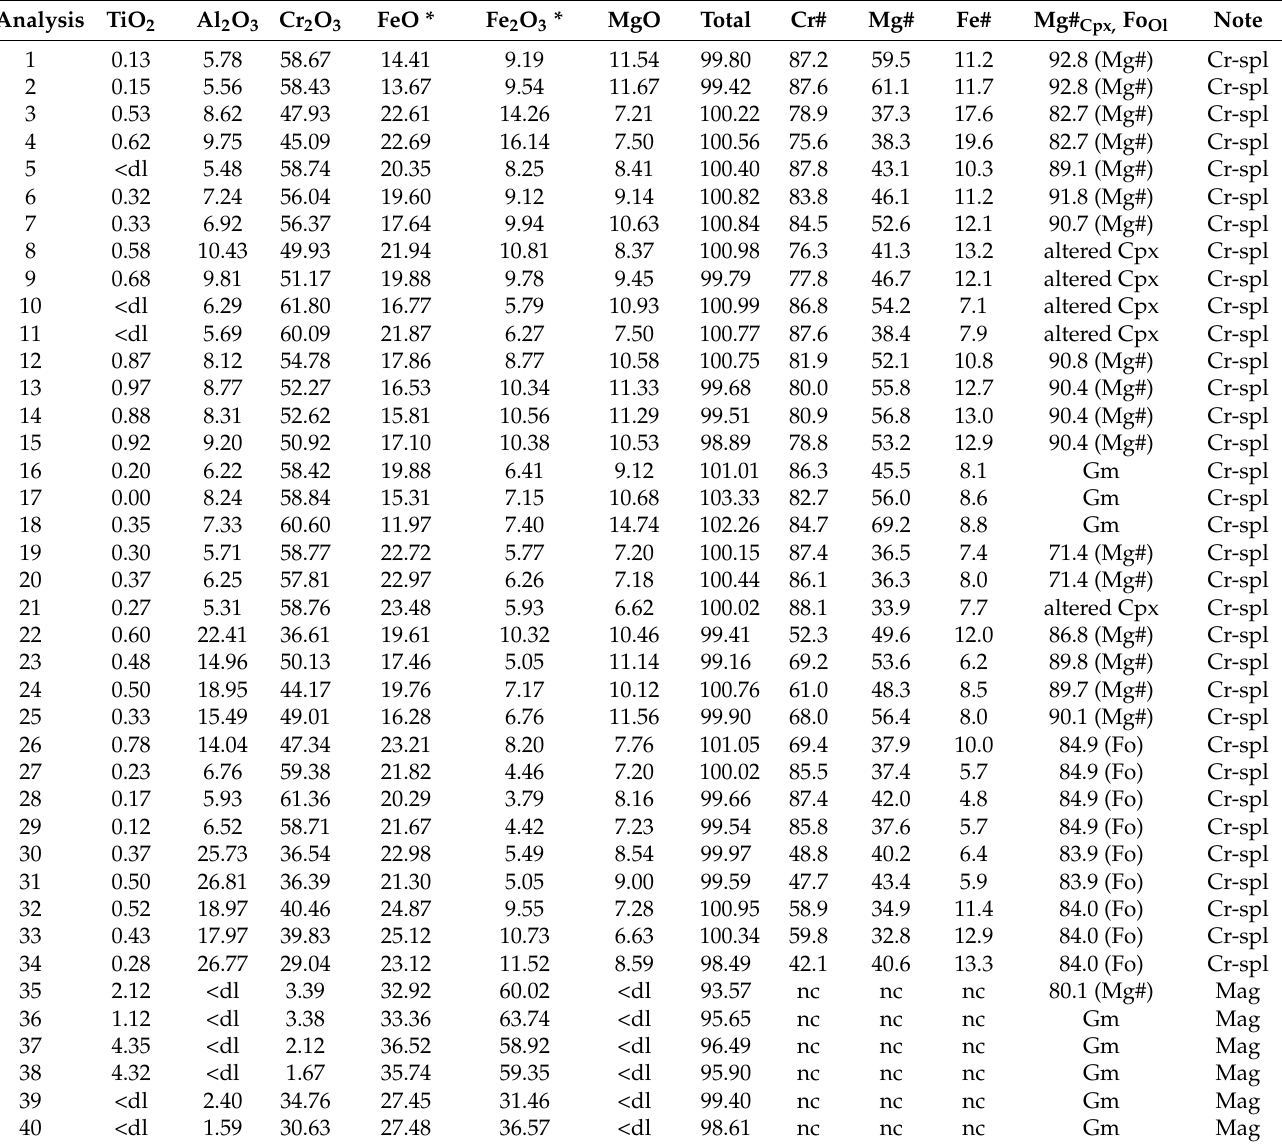
Table 5. Major element composition (by SEM-EDS) of Cr-spinel and magnetite from the Ust’-Sema Formation and the Barangol Complex rocks, Gorny